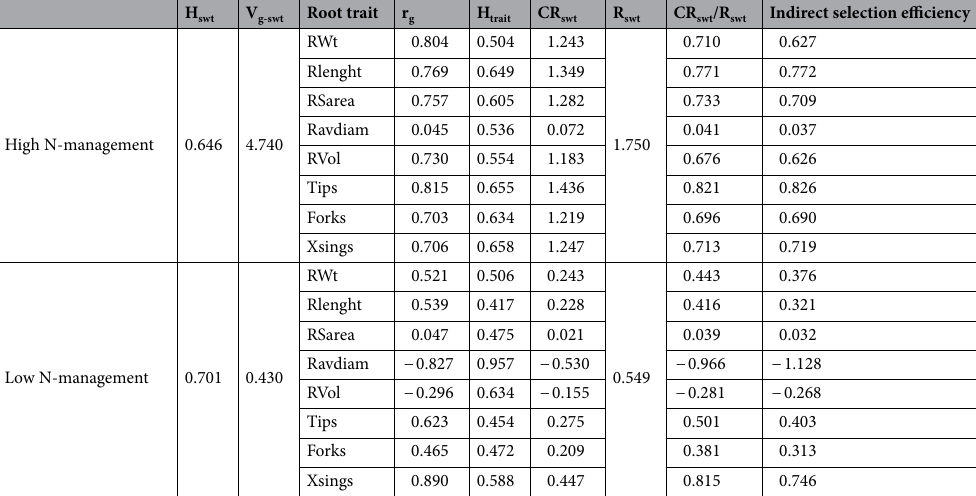
Table 6. Predicting the correlated response and indirect selection efficiency for shoot weight using root traits as the secondary traits under high N-management and low N-management. V g-swt , genetic variance of shoot weight (SWt), r g , genetic correlation between SWt and a root trait, H swt , broad sense heritability (repeatability) of SWt on a line mean basis; H trait, broad sense heritability (repeatability) a root trait on a line mean basis, CR swt , Correlated response; R swt , response to direct selection; Indirect selection efficiency compares H swt to [( r g between SWt and Trait) × H trait